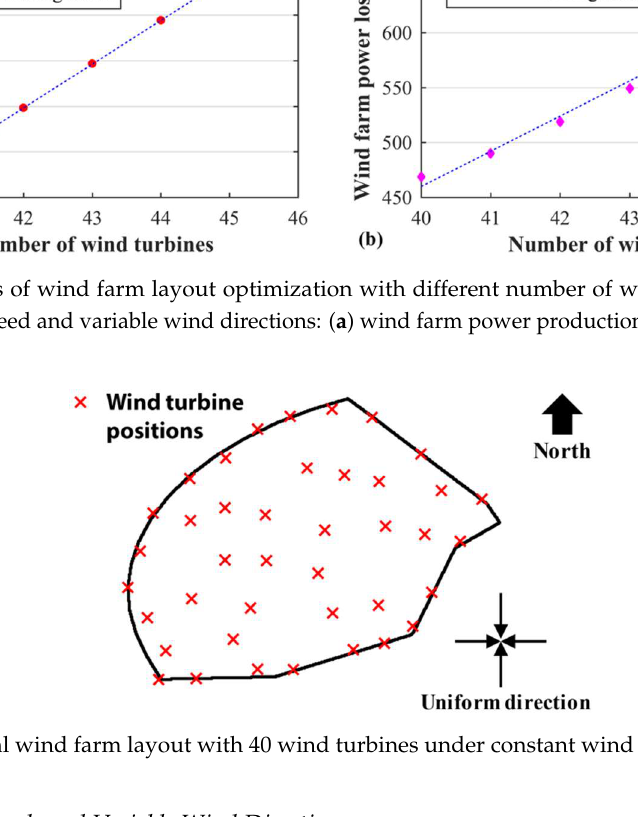
Figure 8. Optimal wind farm layout with 40 wind turbines under constant wind speed and variable wind directions.